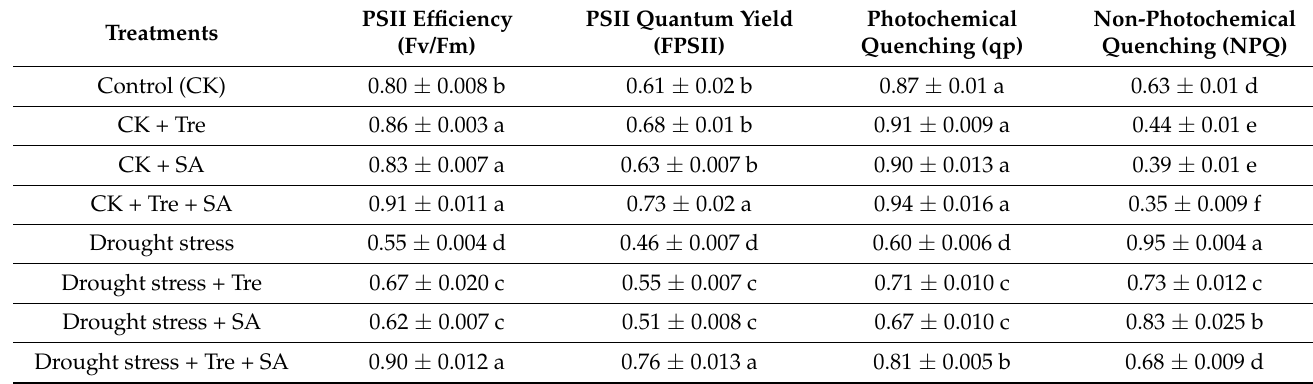
Table 3. Effect of foliar application of 30 mM trehalose (Tre) and/or 1 mM salicylic acid (SA) on chlorophyll fluorescence parameters in sweet basil seedlings grown under well-watered (control, CK) and drought stress conditions. Values are the means ± SE ( n = 6). Different letters within a column indicate significant differences among means according to Duncan’s multiple-range test at the p < 0.05